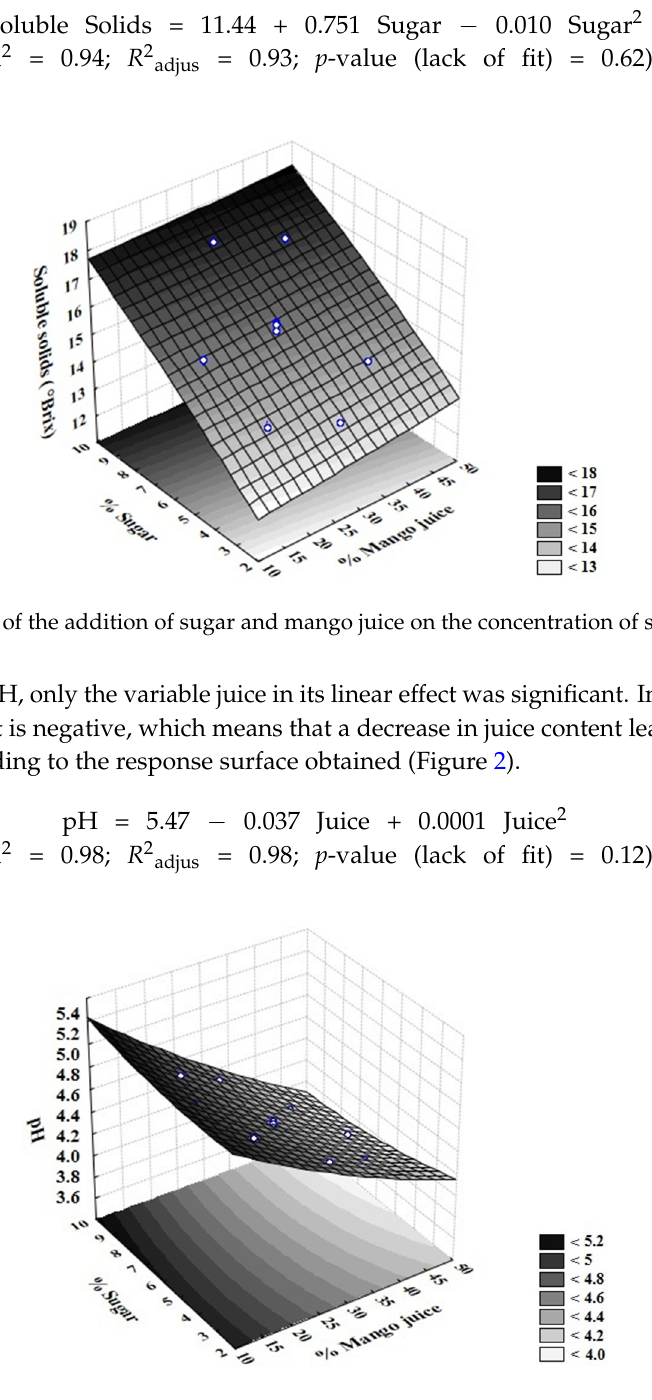
Figure 2. Effect of the addition of sugar and mango juice on the concentration of pH.